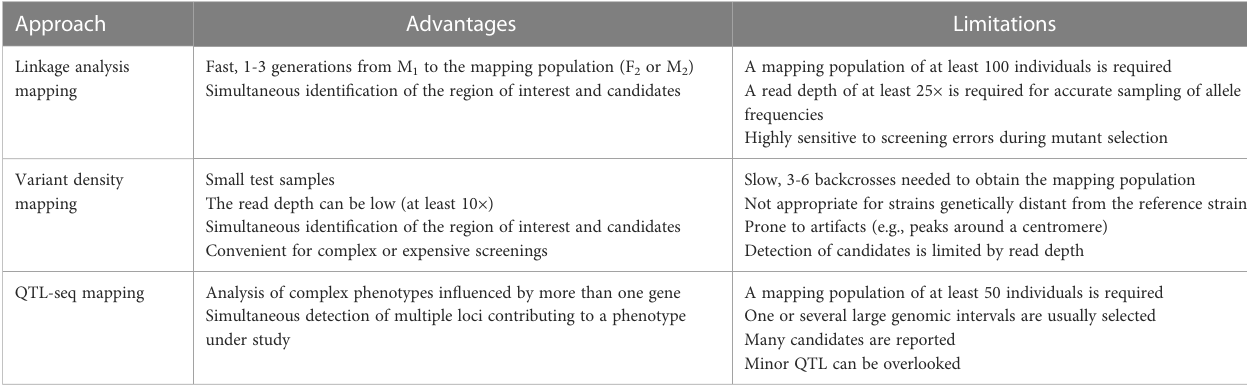
TABLE 1 Experimental approaches for mapping-by-sequencing of SNPs and small InDels. Approach